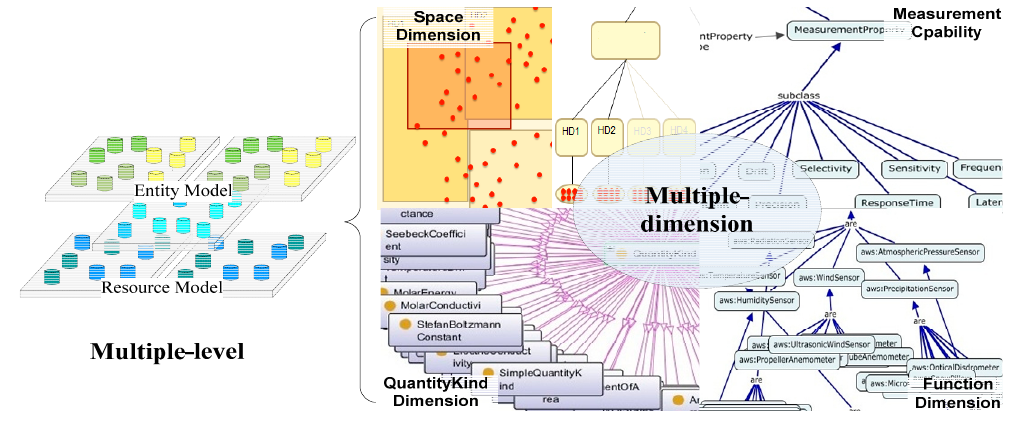
Figure 6. Multilevel and multidimensional model.